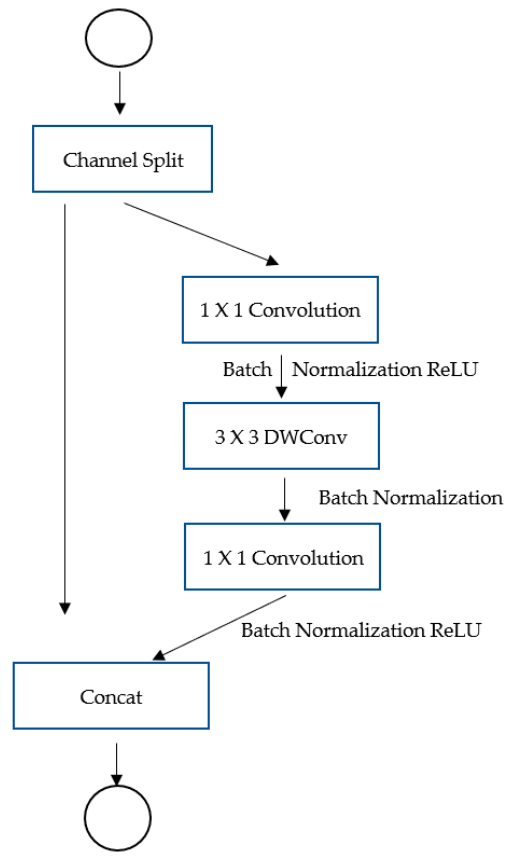
Figure 1. Design of ShuffleNetv2.